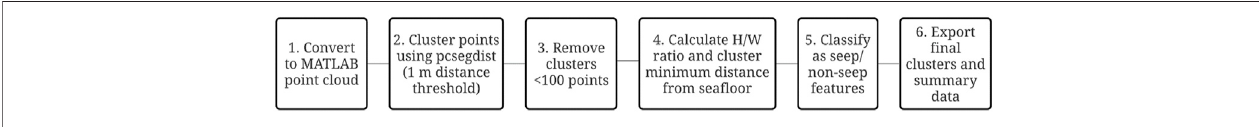
FIGURE 5 | Overview of classi fi cation work fl